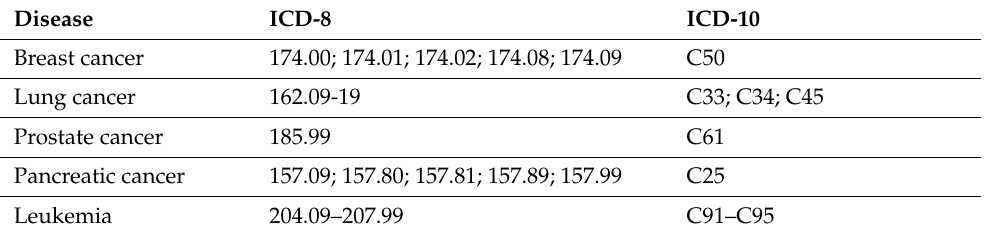
Table 1. ICD-8 and ICD-10 codes utilized to identify diagnoses of outcomes.